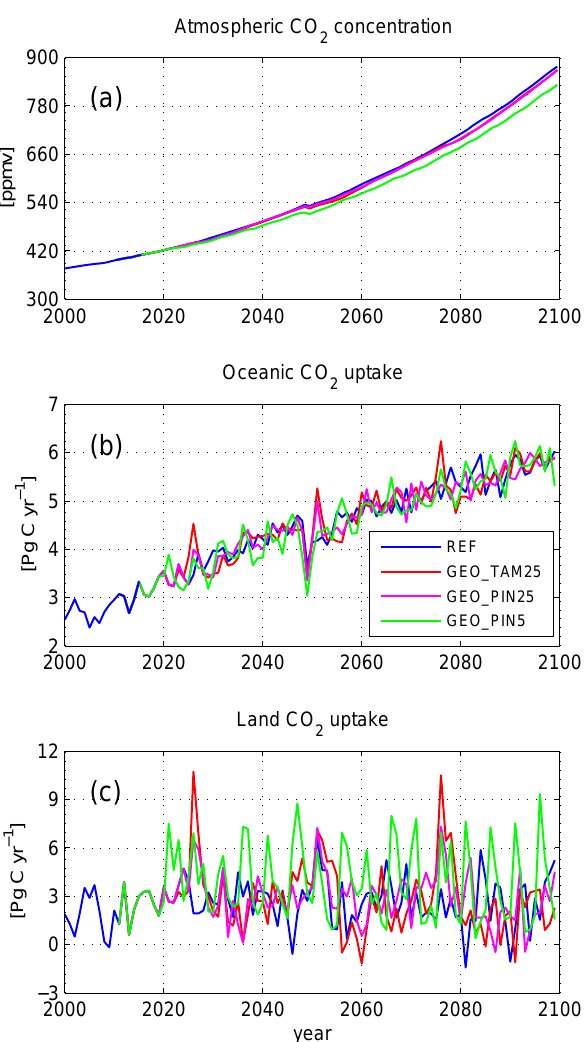
Fig. 5. Model projection of annual mean (a) atmospheric CO 2 con- centration, (b) oceanic carbon uptake, and (c) terrestrial carbon up- take over the 2000–2099